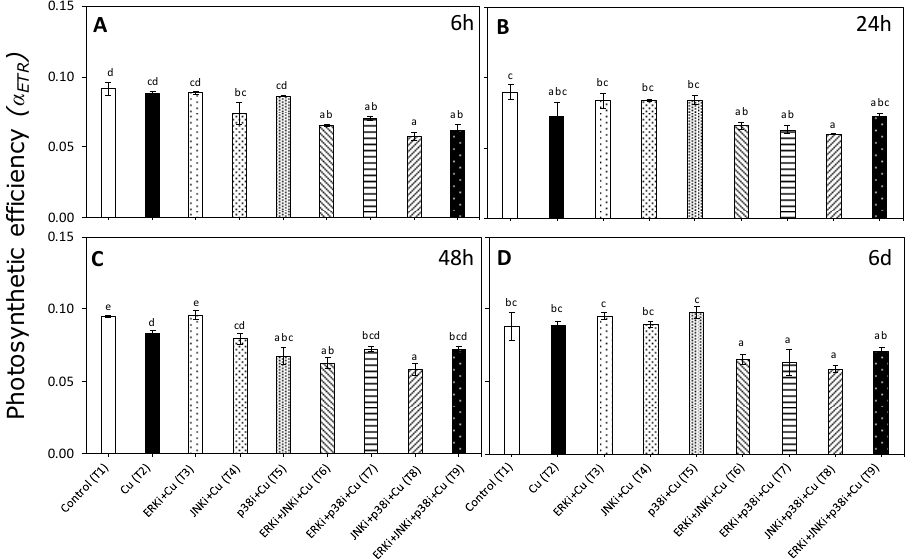
Figure 3. Photosynthetic efficiency ( α ETR ) in U. compressa under copper and / or exposure to MAPK inhibitors. Treatments: T1—control only with seawater; T2—copper only exposure as 10 µ M CuSO 4 (Cu); T3—copper + 5 µM MAPK ERK inhibitor PD98059 (Cu + ERKi); T4—copper + 5 µM MAPK JNK inhibitor SP600125 (Cu + JNKi); T5—copper + MAPK p38 inhibitor SB203580 (Cu + p38i); T6—Cu + ERKi + JNKi; T7—Cu + ERKi + p38i; T8—Cu + p38i + JNKi; and T9—Cu + ERKi + JNKi + p38i. Samples were analyzed after ( A ) 6 h, ( B ) 24 h, ( C ) 48 h, and ( D ) 6 d of treatment. Different letters within each ( n = 3).